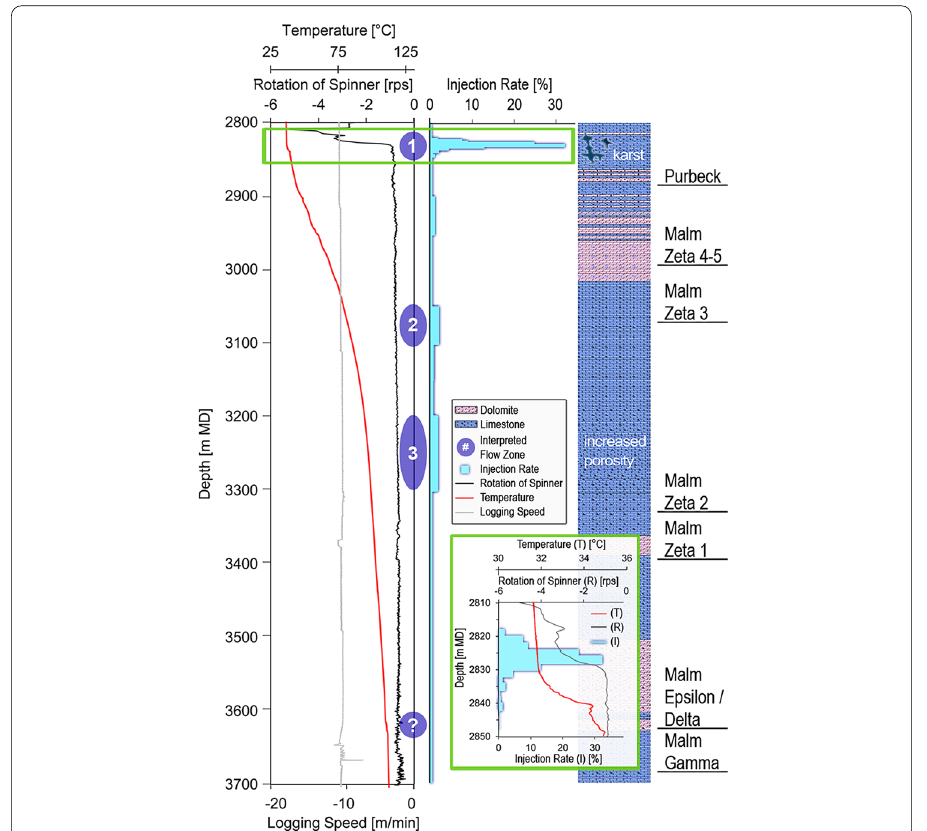
Fig. 6 Interpreted flow zones in producer well together with flowmeter spinner data, temperature and logging speed, lithology and stratigraphic units. Zoom to top section is shown in green framed box